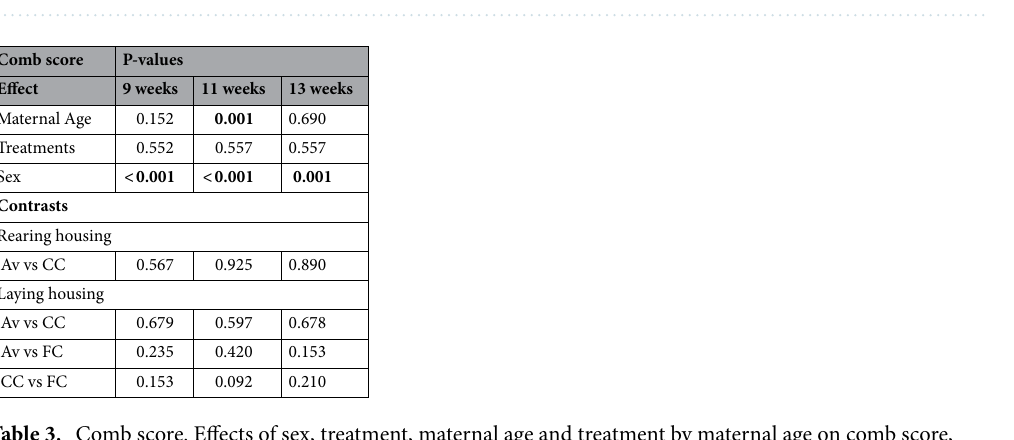
Figure 3. Manual restraint test. Effects of treatment and maternal age on plasma corticosterone concentration (ng/ml) displayed by maternal age. Statistical differences in plasma corticosterone concentration across treatments are indicated by letters (a–d) (P < 0.05).